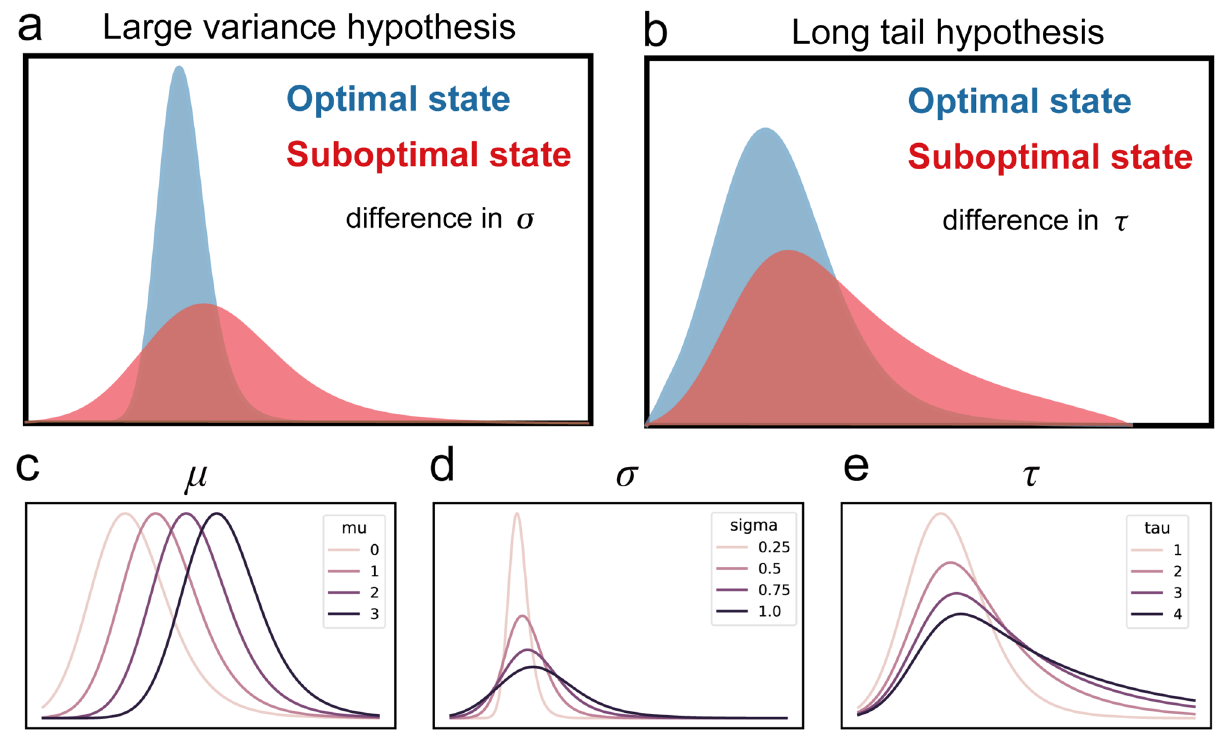
Figure 1. Two alternative hypotheses and exGaussian distributions. ( a ) Illustration of large variance hypothesis. ( b ) Illustration of long tail hypothesis. ( c ) exGaussian distributions with different μ ( μ = {0, 1, 2, 3}, σ = 1, τ = 1). ( d ) exGaussian distributions with different σ ( μ = 0, σ = {0.25, 0.50, 0.75, 1.0}, τ = 1). ( e ) exGaussian distributions with different τ ( μ = 0, σ = 1, τ = {1, 2, 3,